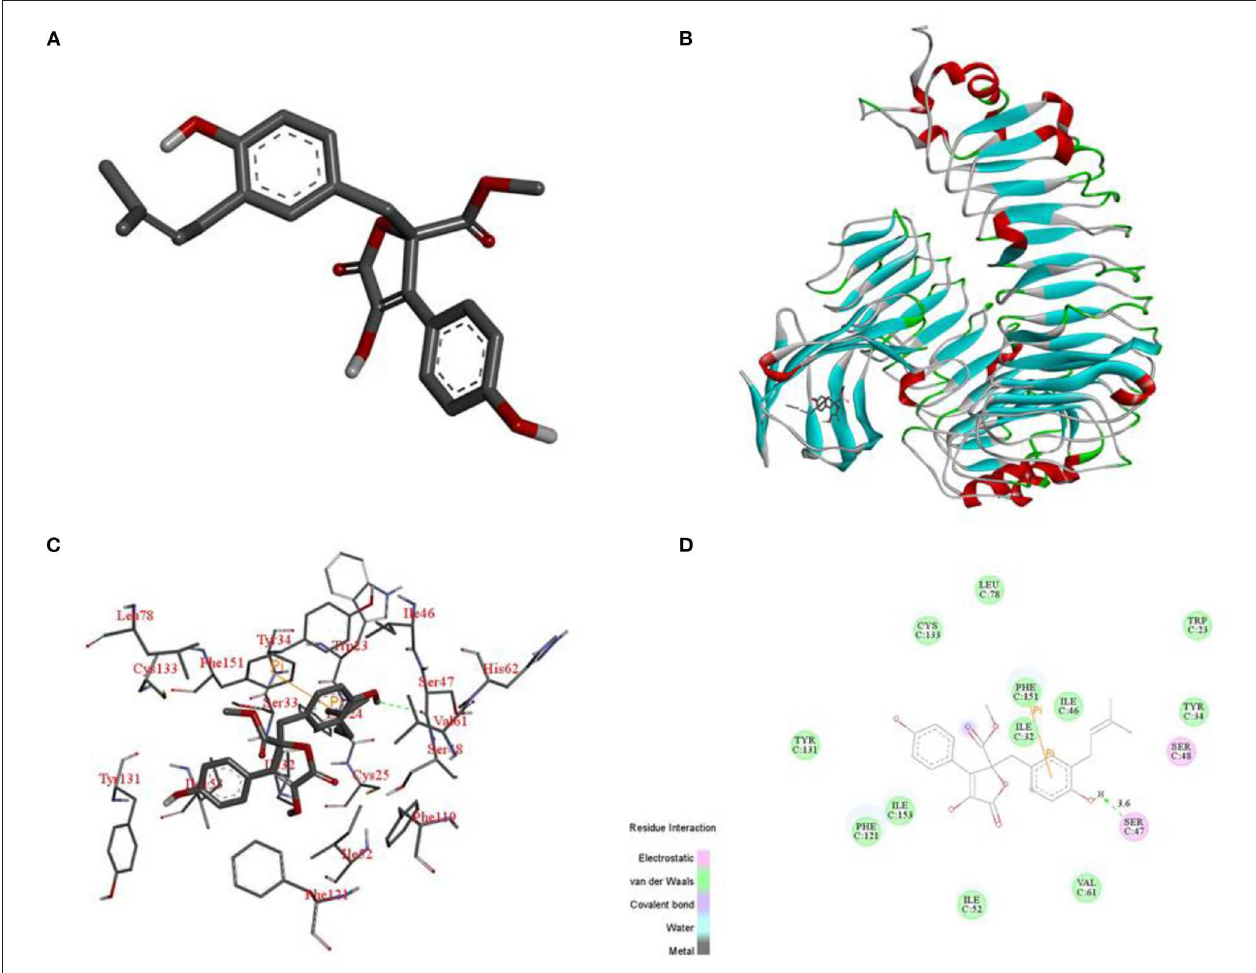
FIGURE 11 | Binding mode of BTL-1 into the TLR4. 3D structure of BTL-1 (A) . Docking of BTL-1 to the active pocket of TLR4 (overall) (B) . Docking of BTL-1 to the active pocket of TLR4 (detail) (C) . Docking of BTL-1 to the active pocket of TLR4 (2D) (D) .